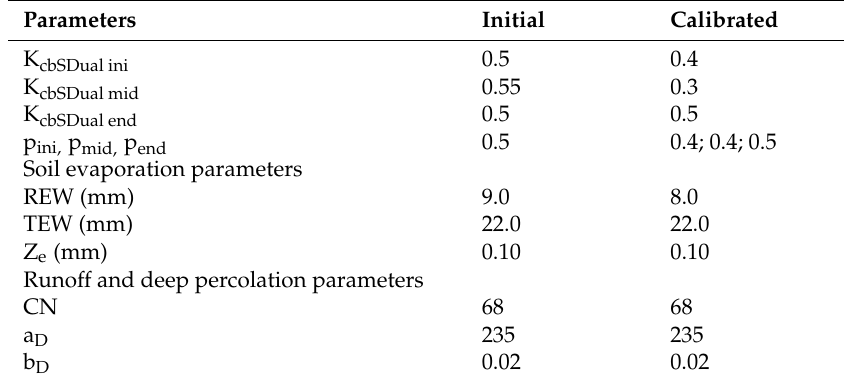
Table 2. Standard and calibrated parameters used in SIMDualKc model (p, depletion fraction, K cb ini , basal crop coefficient for the initial crop development stage, K cb mid , basal crop coefficient for the mid-season stage, K cb end , basal crop coefficient for the end-season stage, TEW, total evaporable water, REW, readily evaporable water, Z e , thickness of the evaporation layer, CN, curve number, aD and bD, deep percolation